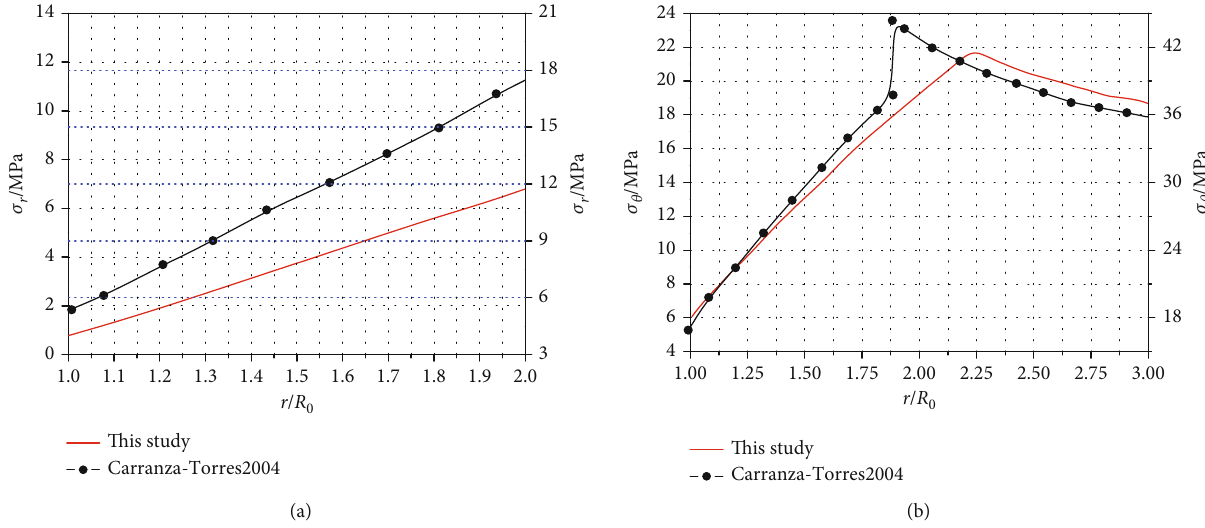
Figure 9: Comparison of stresses curves of GZZ criterion stress with generalized H-B criterion ((a) radial stress; (b) tangential